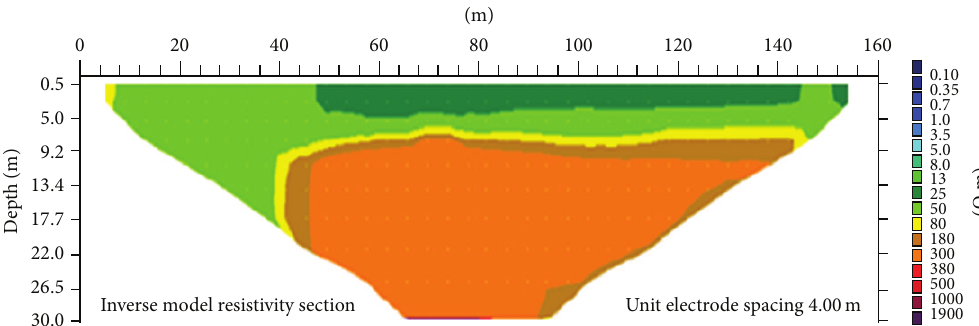
Figure 8: Investigation of 2D resistivity image of second